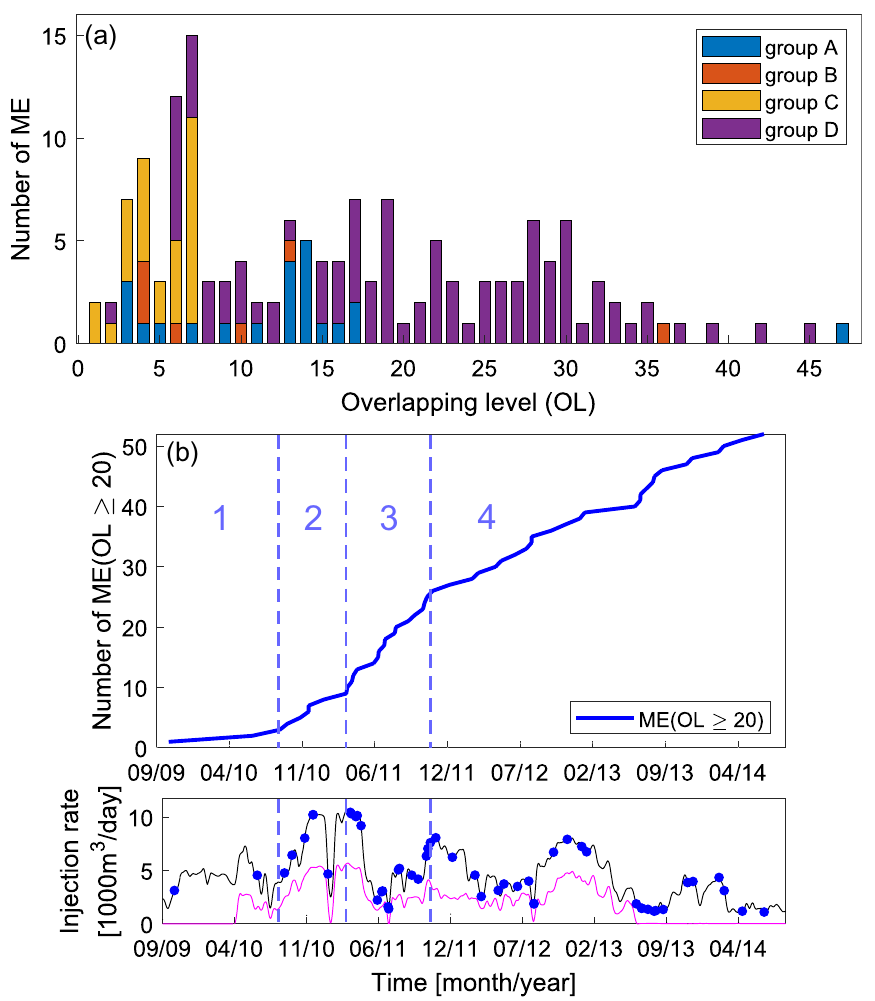
Figure 5. ( a ) Stacked histogram presenting OLs of ME within groups A-D. ( b ) Cumulative occurrence of ME with OL ≥ 20. Distinguished activity rate phases are marked with numbers and vertical dashed blue lines.